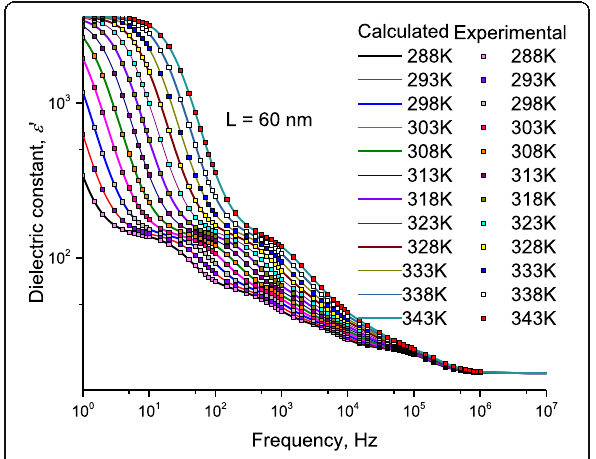
Fig. 20 The frequency dependence of measured dielectric constant ε ‘ at different temperatures. One notices the presence of H1, H2, H3, H4, and